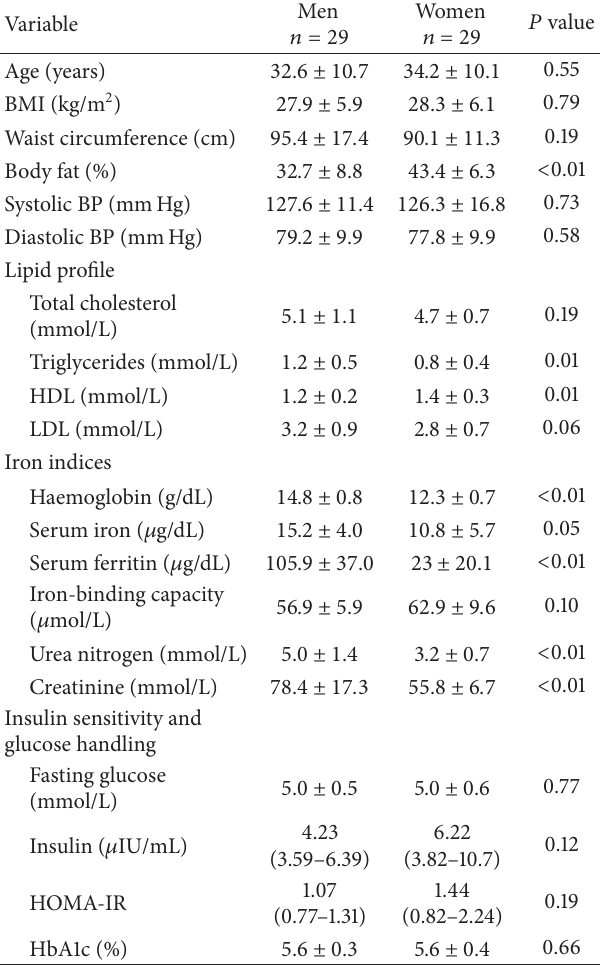
Table 1: Anthropometry, body composition, lipid profile, iron indices,insulinsensitivity,andglucosehandlinginmenandwomen.